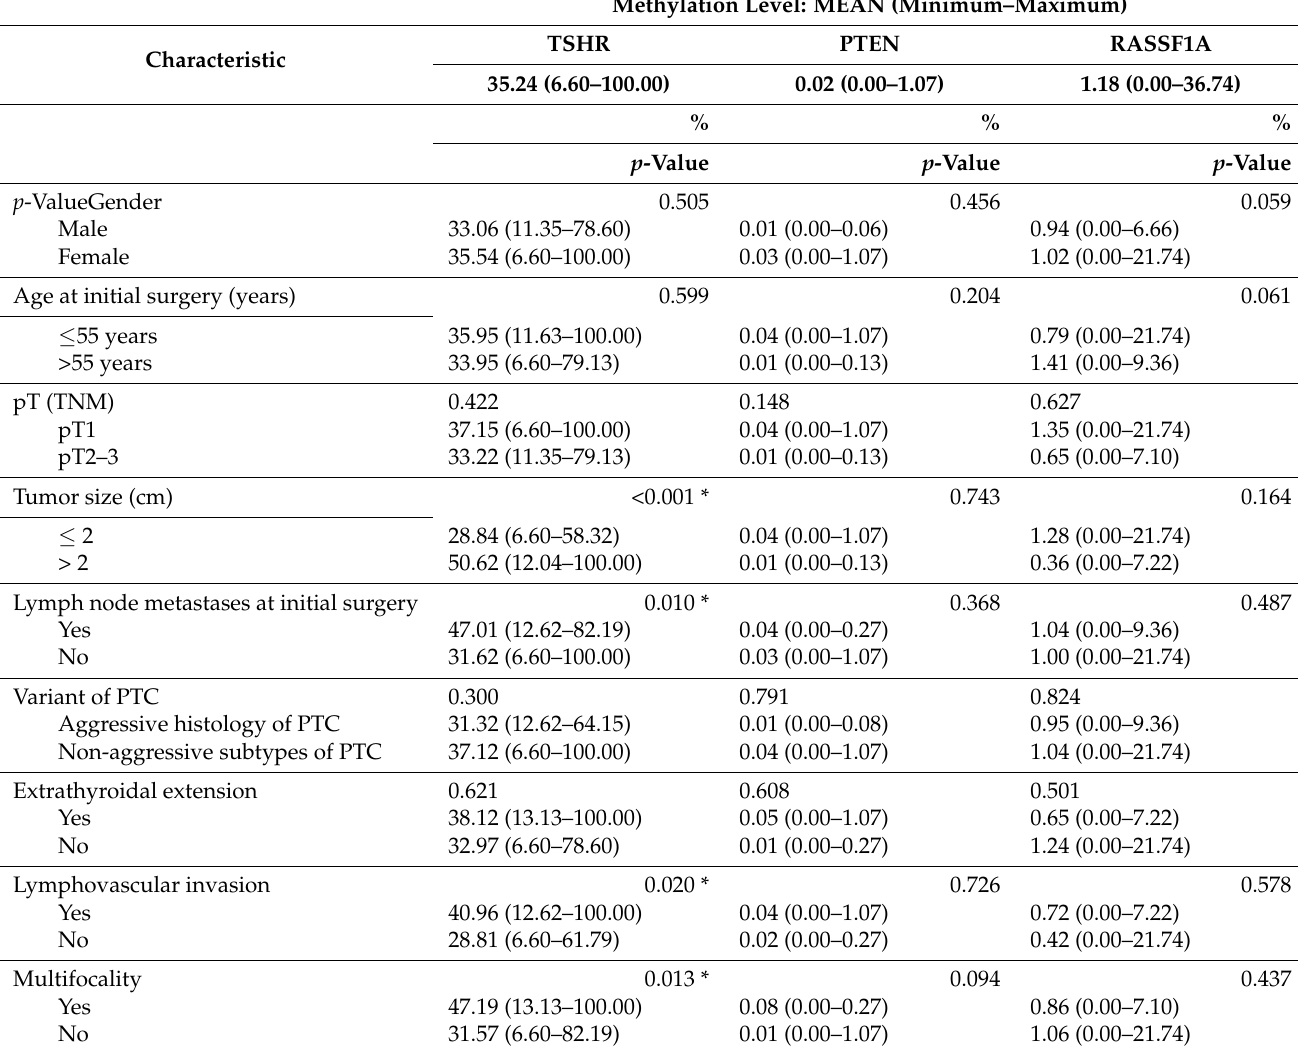
Table 3. Correlation between clinicopathological features of papillary thyroid cancer (PTC)